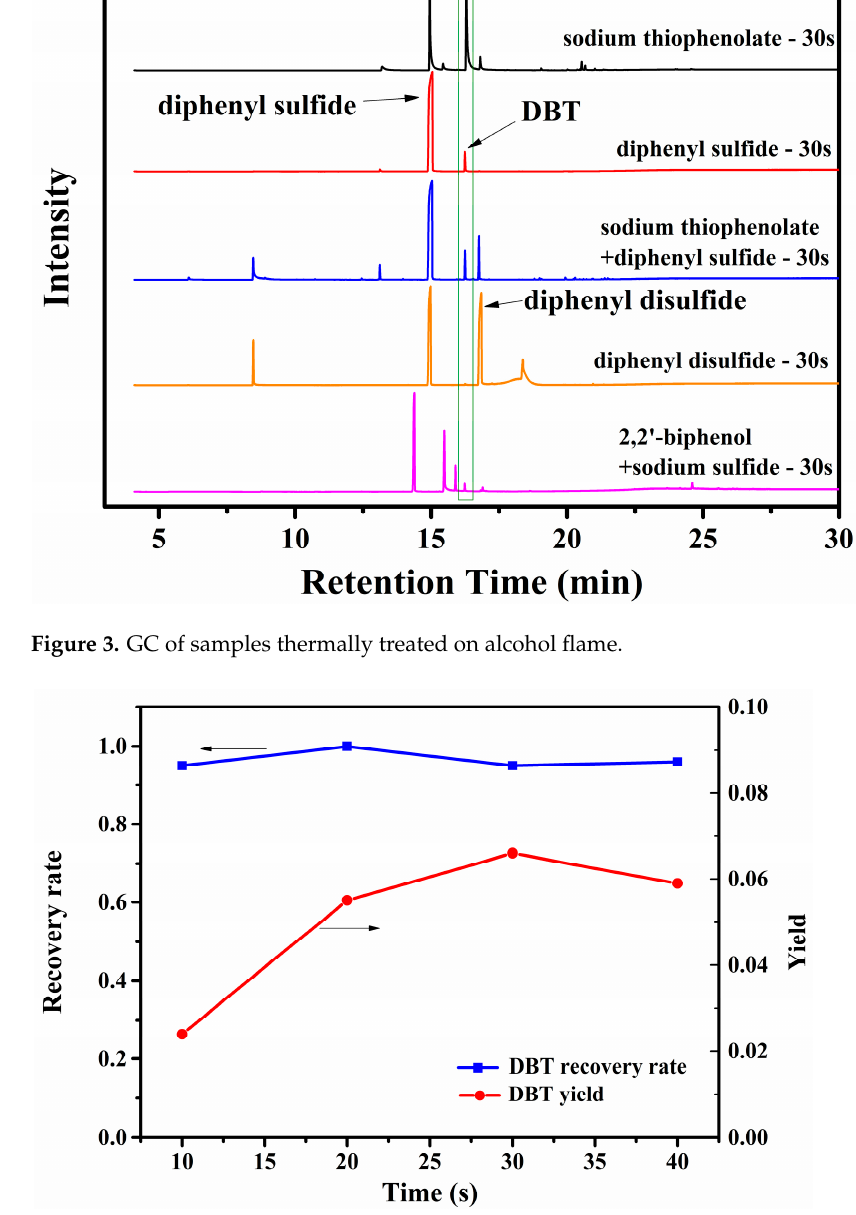
Figure 3. GC of samples thermally treated on alcohol flame.